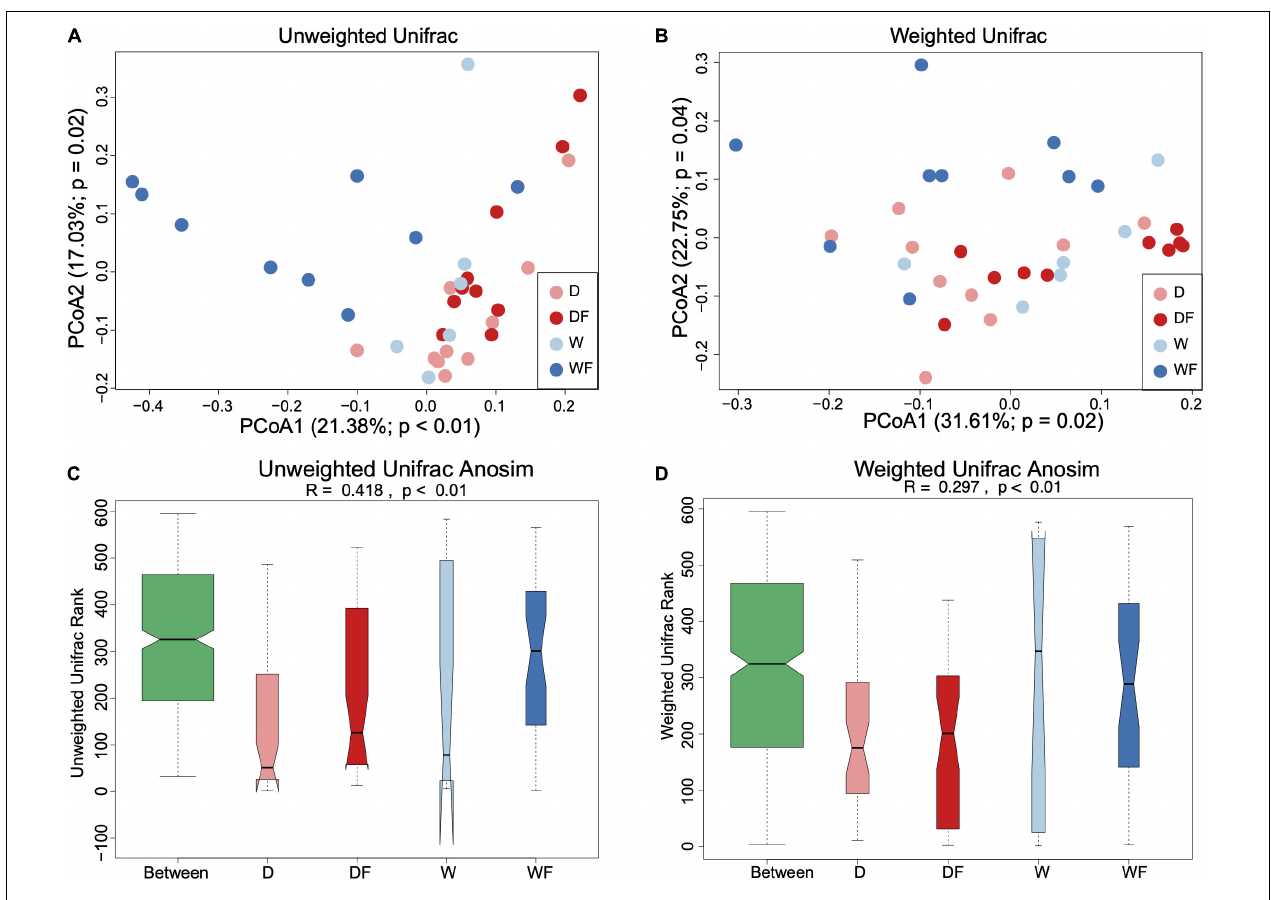
FIGURE 3 | Beta diversity of gut microbiota between mice transplanted domestic pig fecal bacteria and feed a low-fiber diet (D) or high-fiber diet (DF), transplanted wild boar fecal bacteria and feed low-fiber diet (W) or high-fiber diet (WF). Principal coordinates analysis with unweighted Unifrac distance (A) , weighted Unifrac distance (B) , and Anosim analysis for unweighted Unifrac (C) and weighted Unifrac (D) applied for gut microbiota between D, DF, W, and WF